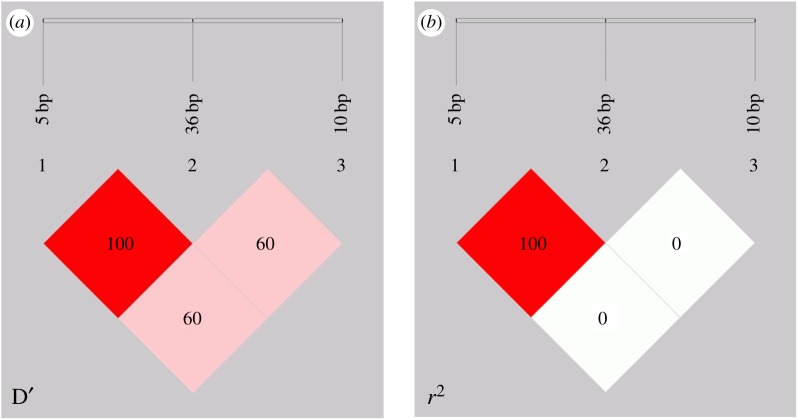
LD plot of the PDGFRB gene three indel loci in goat, 5 bp indel, 36 bp indel and 10 bp indel. (a) D′ value, (b) r2 value.